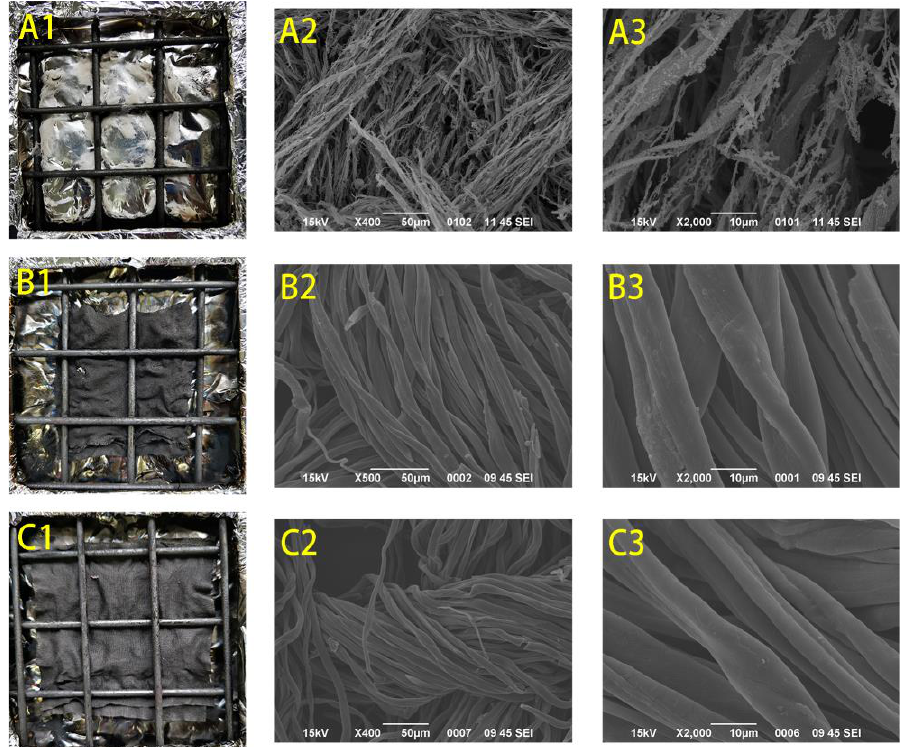
Figure 6. SEM micrographs (×400 and ×2000) of the control ( A1 – A3 ), PAP-200 ( B1 – B3 ), and PAPBTCA-200 ( C1 – C3 ) after CCT.